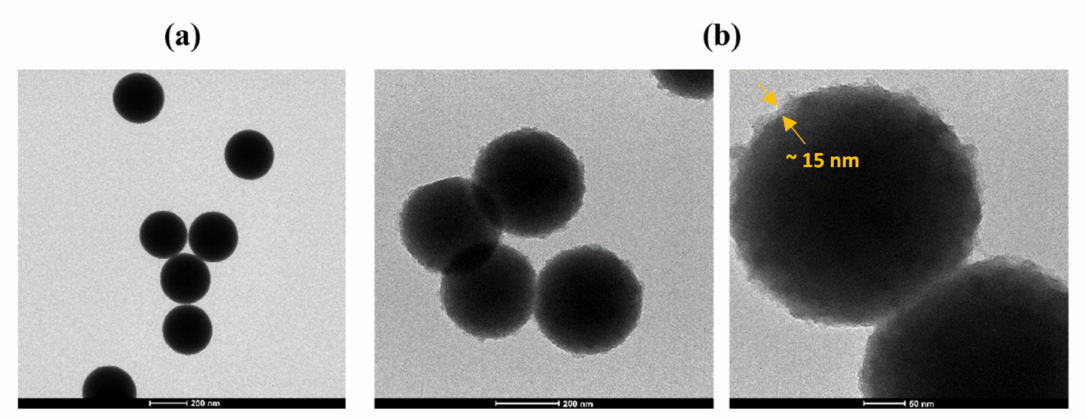
Figure 3. TEM micrographs of ( a ) bare silica NPs and ( b ) SiO 2